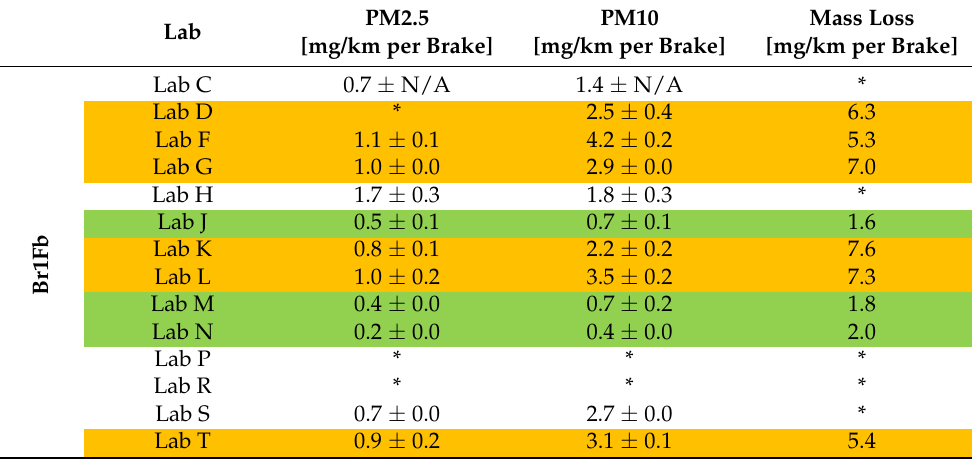
Table 11. PM10, PM2.5, and mass loss emission results of Br1Fb from all testing facilities. Orange cells denote testing facilities that measured high mass loss. Green cells denote testing facilities that measured low mass loss. ± indicates the standard deviation of the three measurements–mass loss measurements were one-off. Asterisks denote testing facilities not carried out emissions or mass loss measurement for this brake. N/A indicates measurements not repeated three times as defined in the protocol. PM2.5 PM10 Lab [mg/km per Brake] [mg/km per